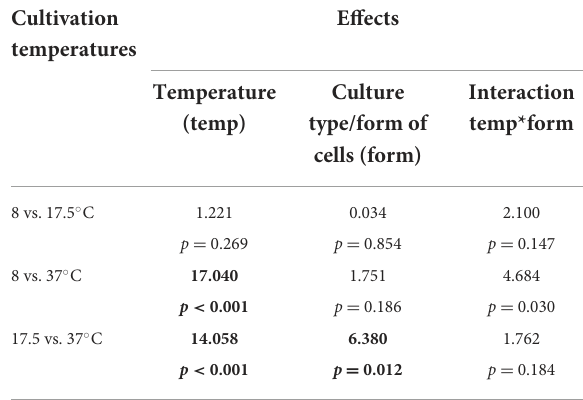
TABLE 2 Influence of cultivation temperature (8, 17.5, and 37 ◦ C) and culture type/form of cells (adherent vs. in-suspension cells) on cell